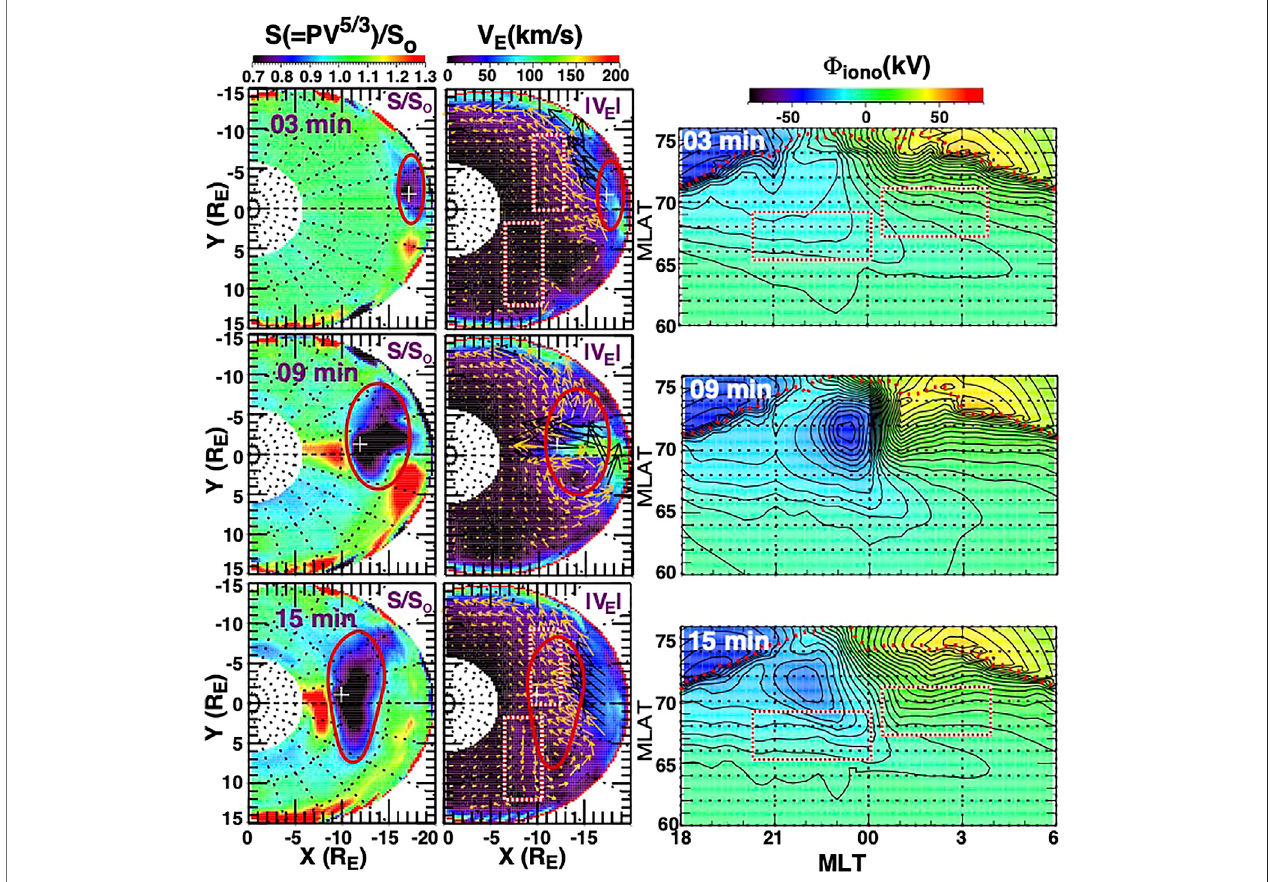
FIGURE 1 | UCLA-RCM results in the equatorial plane and ionosphere from Run one of Wang et al. (2018a) for times 3, 9, and 15 min after a meso-scale perturbation with a 1 h in MLT width and centered at 24 MLT was imposed on the RCM outer boundary A cross-polar cap potential drop of 90 keV was used. The perturbation had adensity decrease byafactor ofsixand atemperature increase byafactor of6. Theleftcolumnshows theratioof fl ux tubeintegratedentropyStothe integratedentropyS o att (cid:1) 0,andthemiddlecolumnshowstheelectric fi elddriftvelocityV E .Bothareofthesecolumnsareintheequatorialplane.Intheleftpanel,a crimson curve outlines the approximate boundary of the expanding bubble for each of the three times. In the middle column, red and white rectangles are drawn tohelp identify the locations for comparing V E at t (cid:1) 3 and t (cid:1) 15 min. Electric potential and equipotential contours are shown in the right